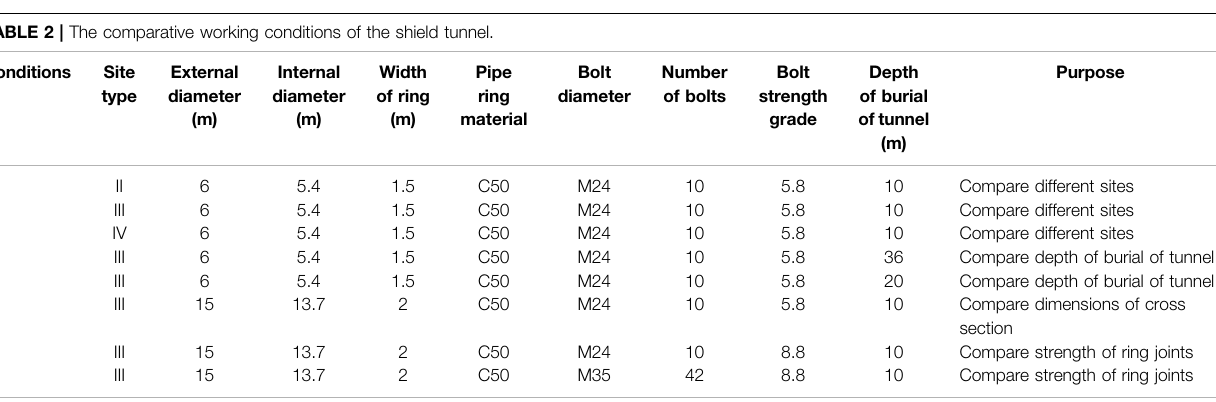
TABLE 2 | The comparative working conditions of the shield tunnel.